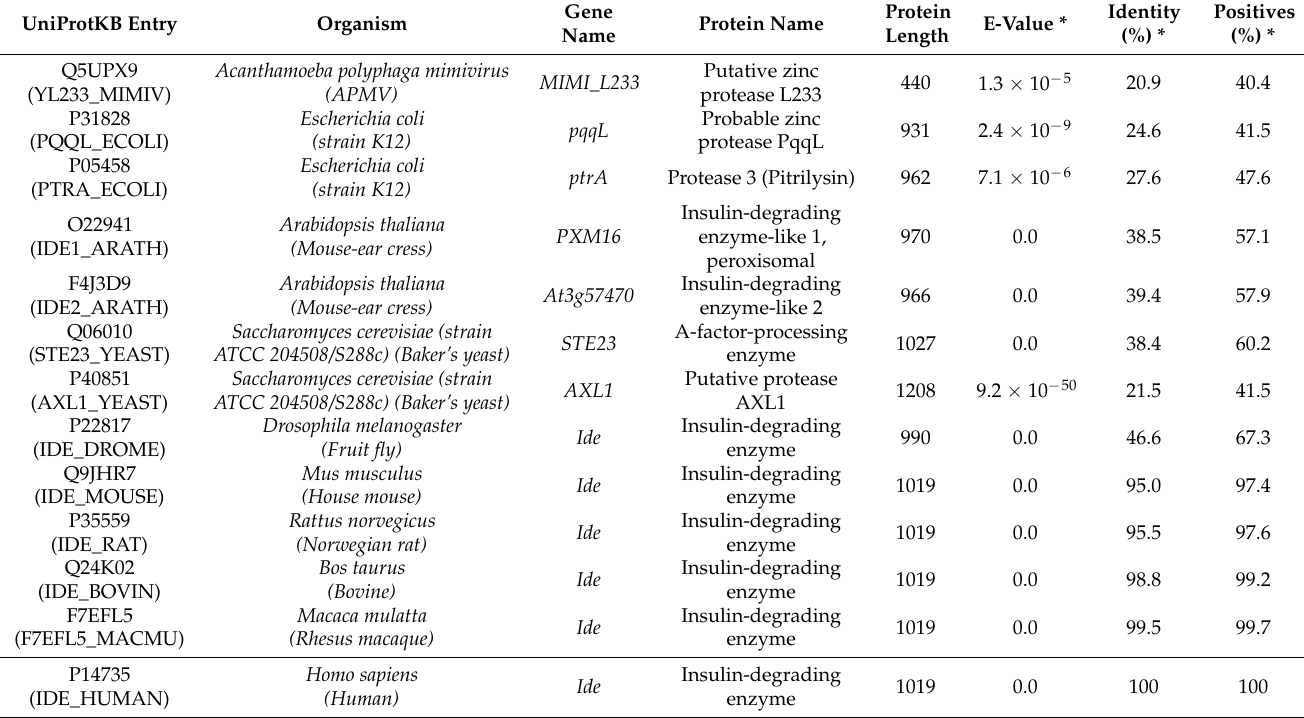
Table 1. Orthologs of insulin-degrading enzyme